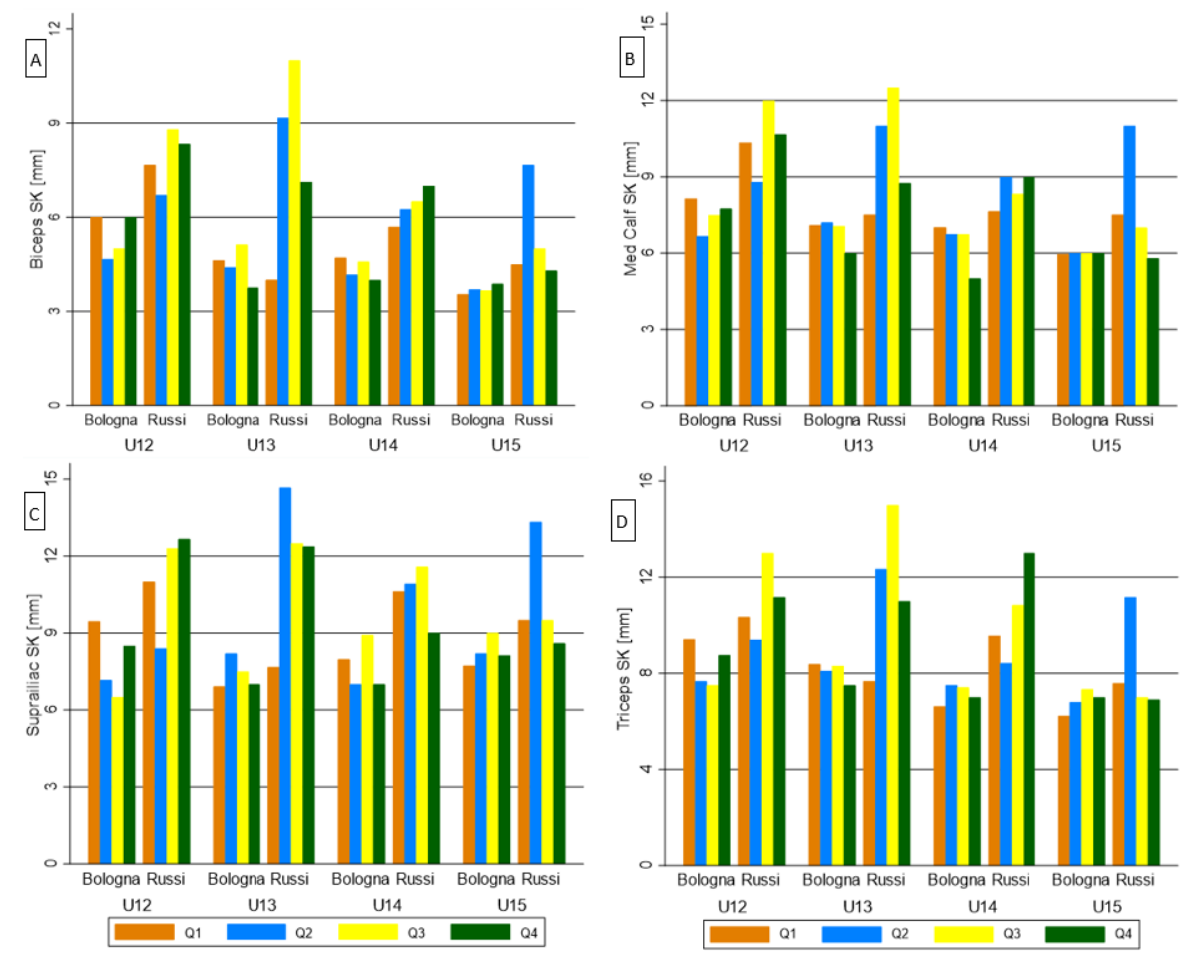
Figure 5. Bar graph of the Relative Age Effect on anthropometric competition level discriminants, among teams and categories: ( A ) Biceps SK; ( B ) Suprailiac SK; ( C ) Medial Calf SK; ( D ) Triceps SK.